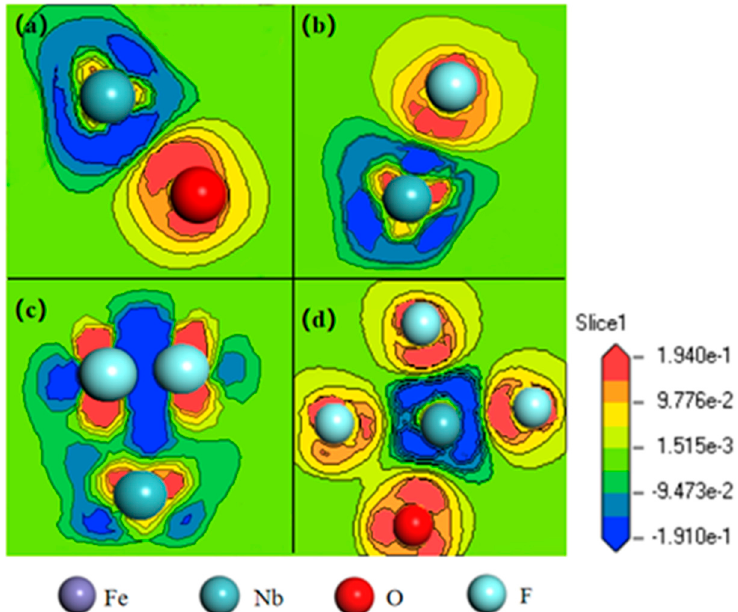
Figure 7. Electron density difference on (110) surface in different systems before and after acid leaching: ( a ) Nb atom combined with O atom on FeNb 2 O 6 (110) surface ( b ) Nb atom combined an F atom on FeNb 2 O 6 (110) surface ( c ) Nb atom combined 2 F atoms on FeNb 2 O 6 (110) surface ( d ) Nb atom combined 3 F atoms on FeNb 2 O 6 (110) surface.